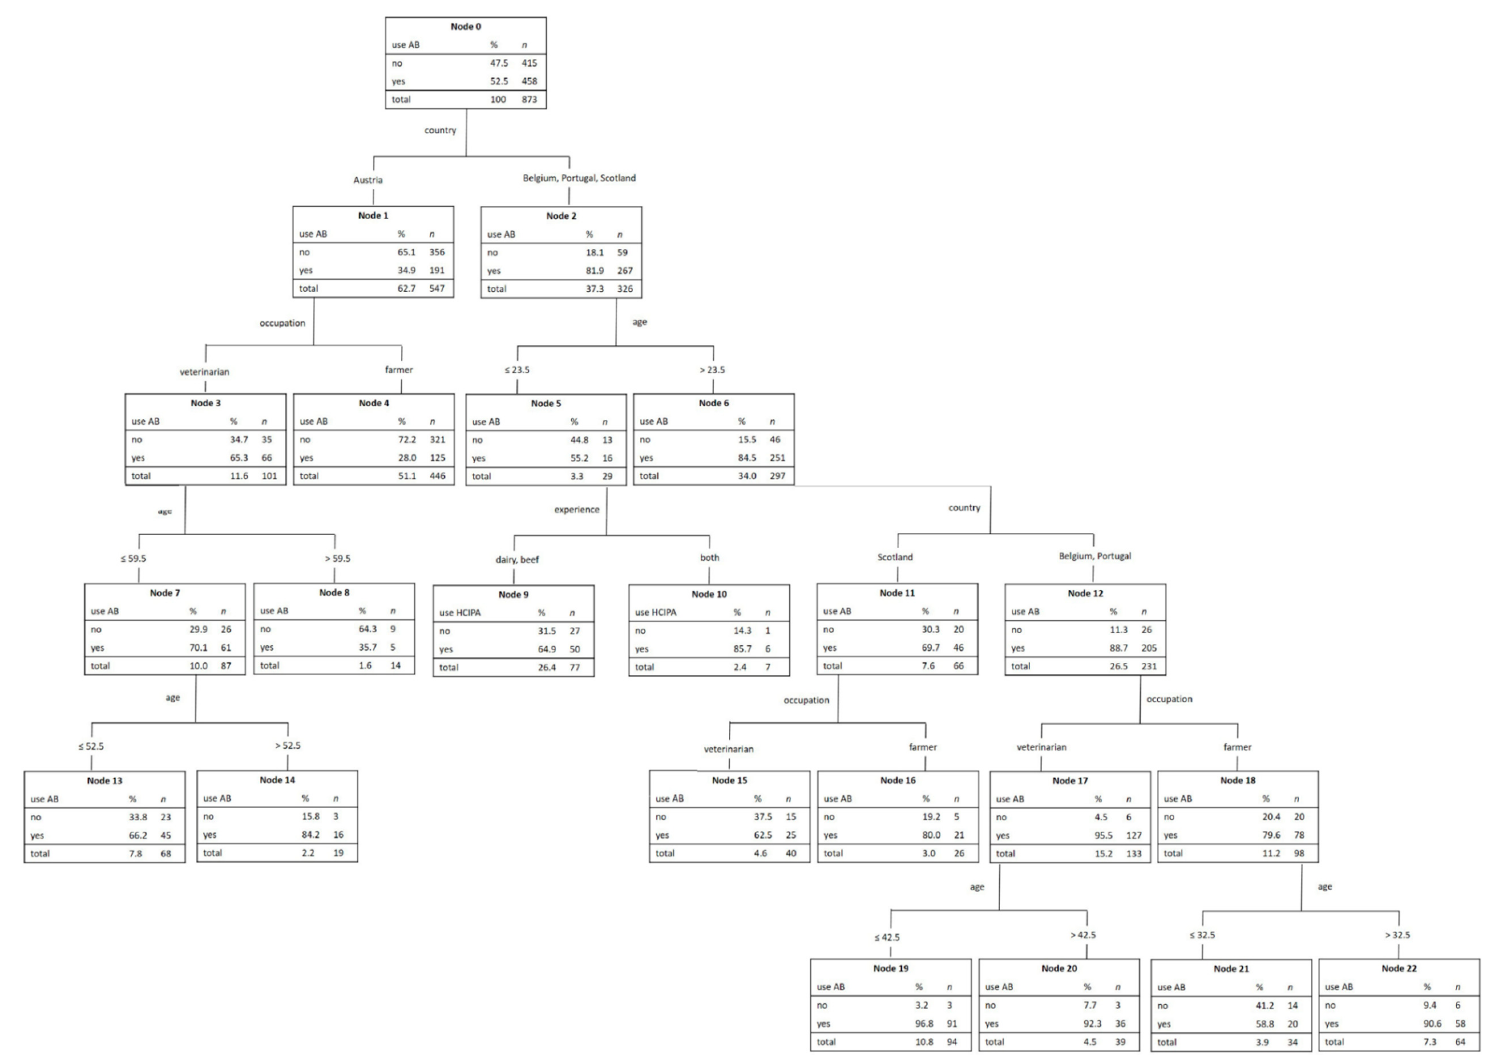
Figure 1. CART: Association of different factors on the use of antibiotics for the treatment of